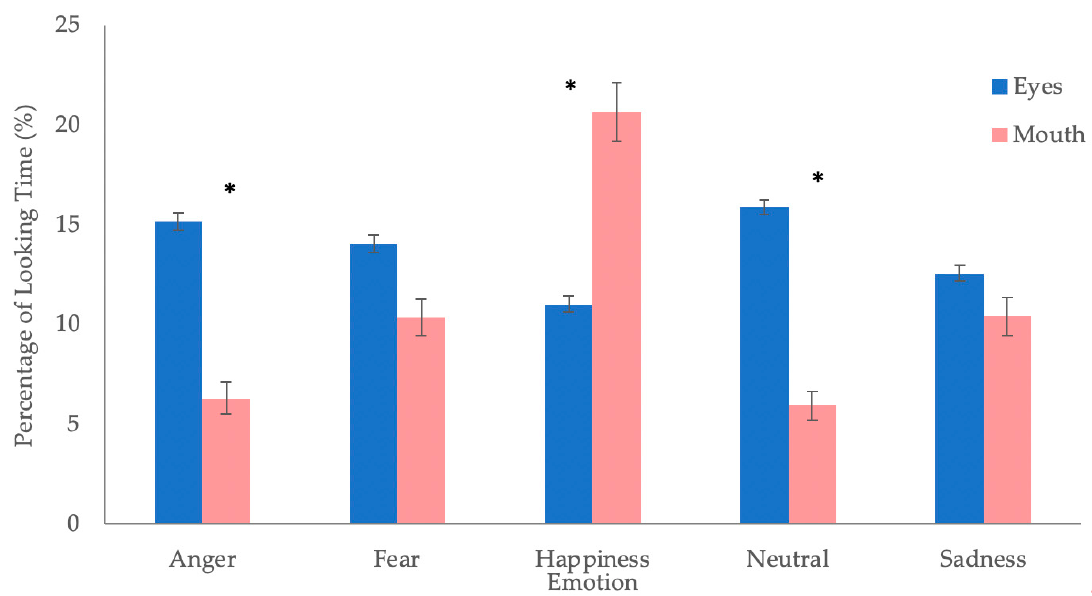
Figure 2. Percentage of looking time towards the critical features (eyes, mouth) for each of the five emotions. ( n = 63) * p < 0.01, adjusted p < 0.02.